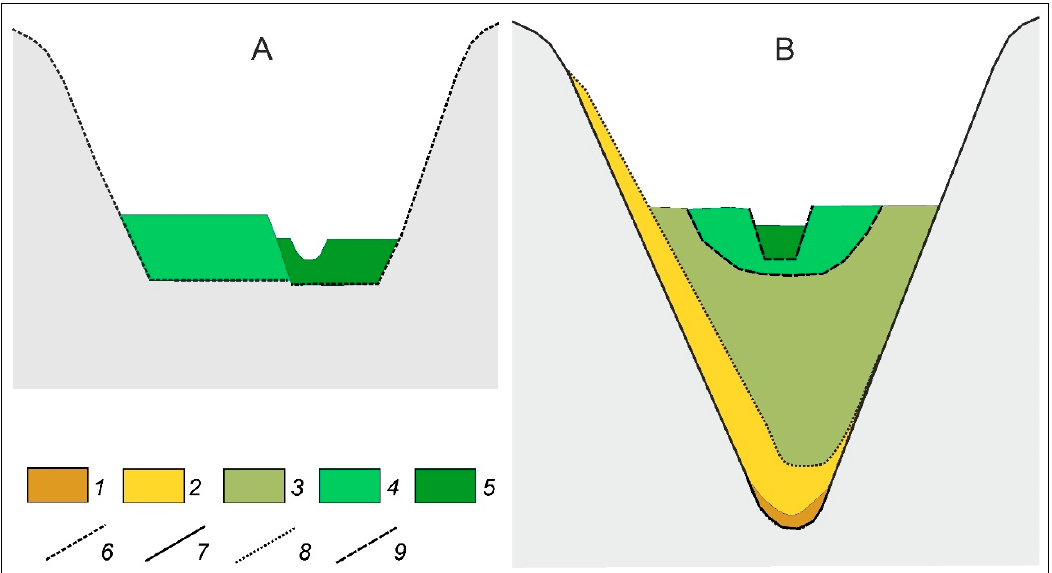
Figure 16. Typical cross-sections of the northern ( A ) and southern ( B ) types of dry valleys (balkas) in the East European Plain. Keys: 1–5—depositional series: 1—the Last Interglacial deposits and paleosoil (MIS 5e), 2—the Early Valdaian sediments (MIS 4), 3—the Late Glacial (late MIS 2), 4—the Early and Middle Holocene and 5—the Late Holocene sediments; 6–9—the main erosion surfaces (ES): 6—heterochronous ES (from MIS 6 to the Holocene), 7—ES of the end of MIS 6, 8—ES of the end of MIS 2, 9—the Holocene ES.